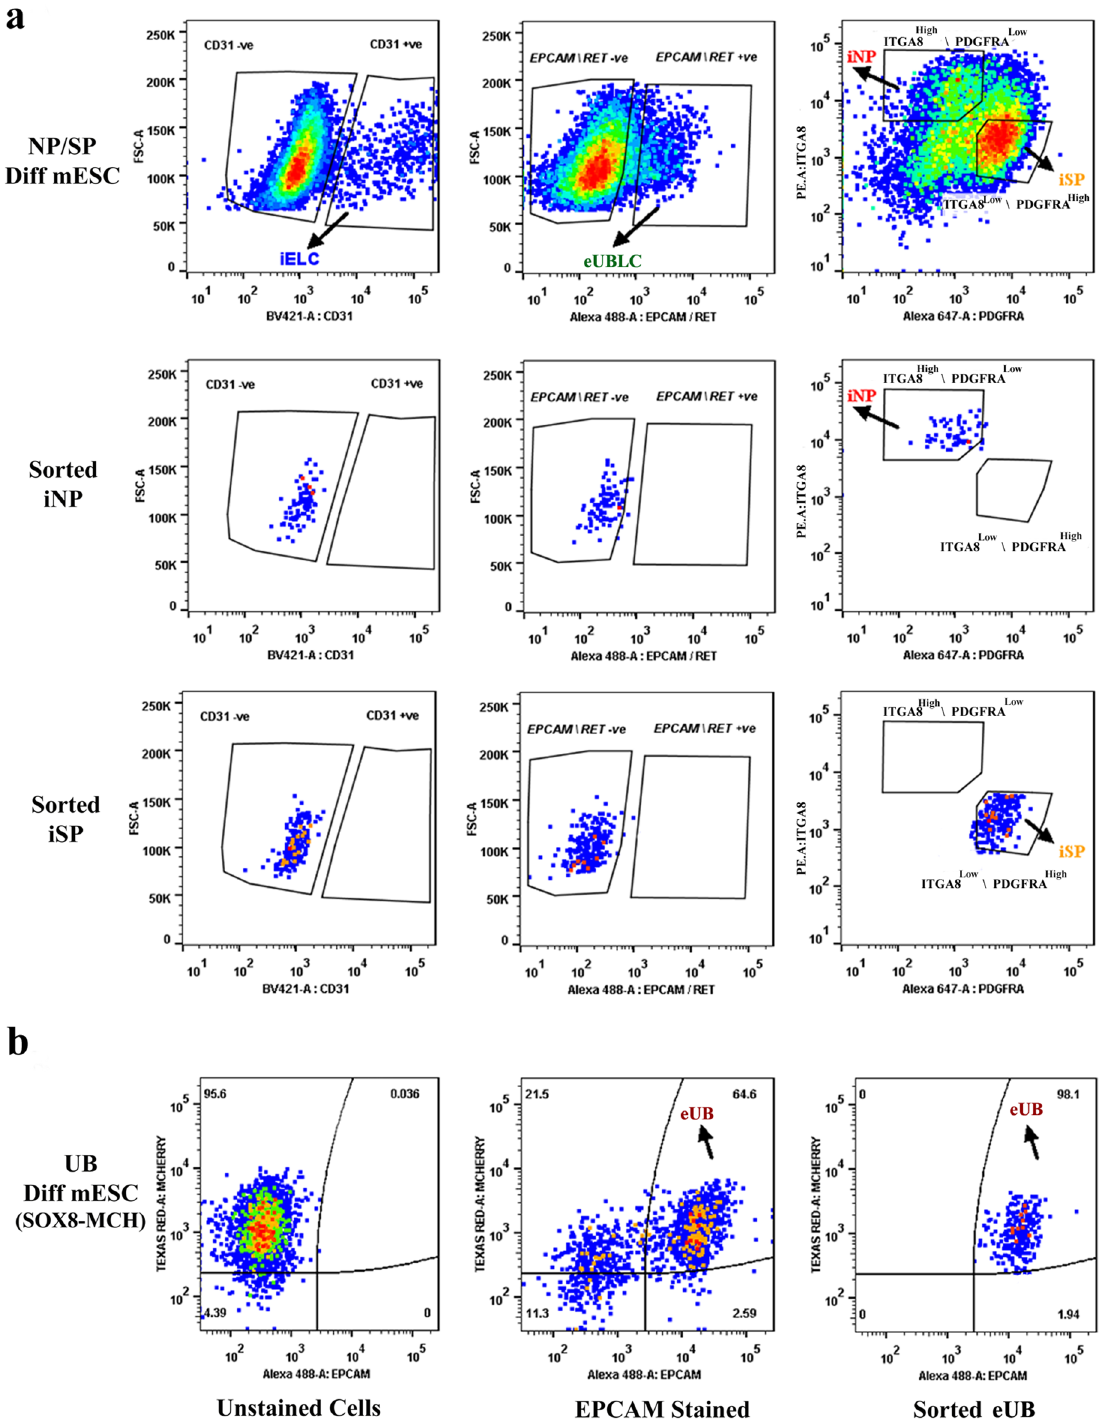
Figure 3. Purity of sorted progenitors from differentiated mESC cells. The top 3 rows refer to embryoid bodies differentiated towards iNP/ iSP cells and the bottom row refers to those differentiated towards eUB. ( a ) The top row shows profiles of unsorted iNP/ iSP-differentiated mESC with respect to the endothelial marker CD31, the ureteric bud markers EpCAM/RET, and the sorting profile based on ITGA8 and PDGFRA. The other rows show post-sorting populations of iNP and iSP: it can be seen that they are free from endothelial (iELC: induced endothelial-like cells) and ureteric bud (eUBLC: engineered ureteric bud like cells) contamination. ( b ) shows the staining profile of eUB-differentiated embryoid bodies with respect to SOX8-mCherry and EpCAM, the sorting profile, and the purity of the resultant sorted